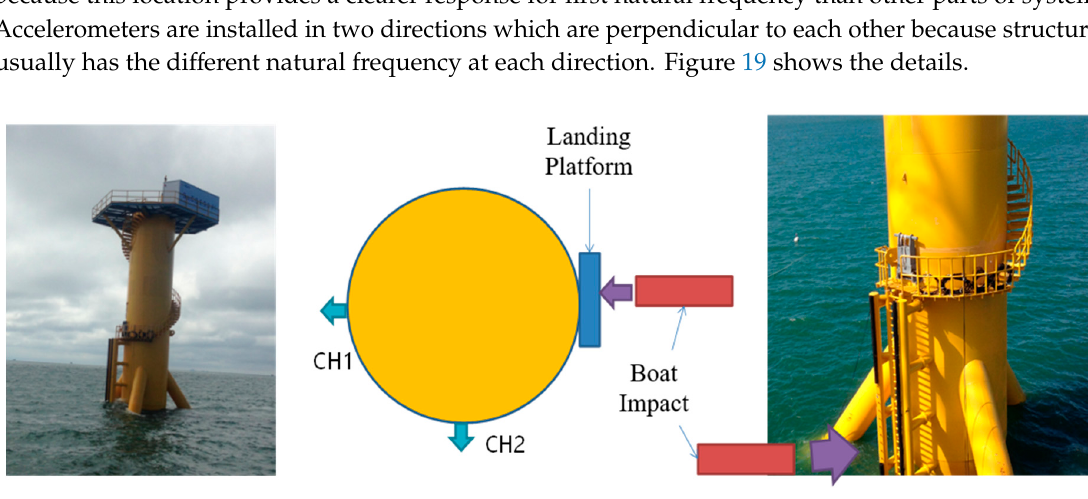
Figure 19. Measuring points of transition piece of wind turbine.